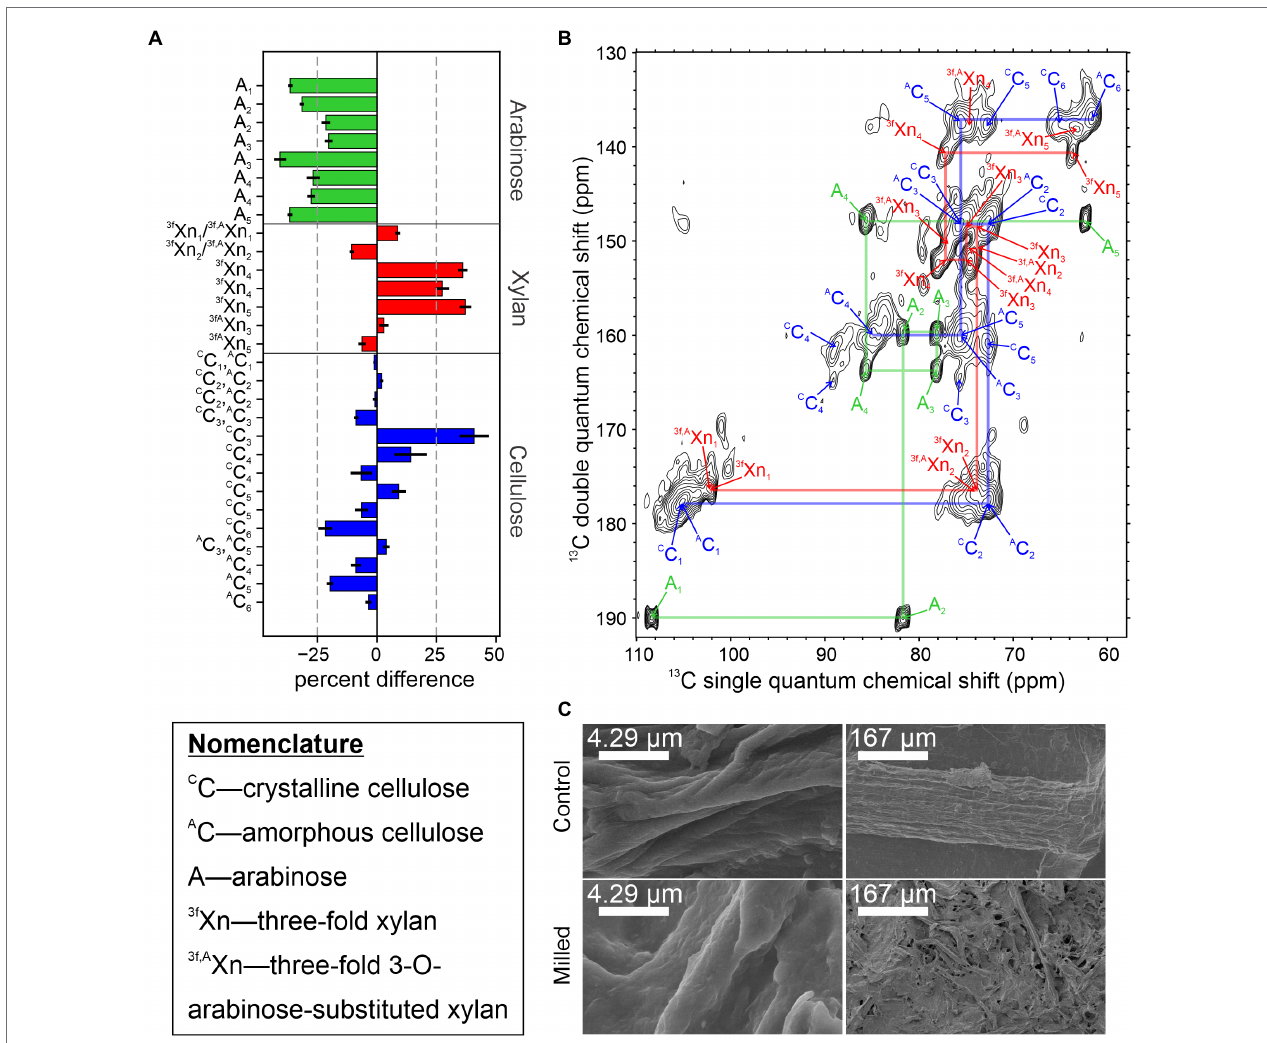
FIGURE 2 | Changes in the rigid structure of sorghum stem tissue after 2 min of ball milling. (A) Percent difference in integrated signal intensities from the 2 min ball-milled sample, relative to the unprocessed control sample. Due to the nature of the CP-INADEQUATE experiment, two signals are observed for most sites. Severely overlapping signals were omitted from this analysis. Error bars derive from the root-mean-squared noise in the spectra. (B) The CP-INADEQUATE spectrum of the unprocessed control sample. Semi-transparent lines are drawn to show the connections between signals within amorphous cellulose (blue), 3-fold xylan (red), and arabinosyl units from xylan (green). The spectrum was recorded at a 1 H frequency of 500 MHz with 10 kHz magic angle spinning and high power 1 H decoupling. (C) Field emission SEM images of the 2 min ball-milled and control samples. For all experiments, sorghum Tx430 was grown to maturity in a custom 13 CO 2 chamber as previously described (Gao and Mortimer, 2020), and the material used here had at least 92% 13 C incorporation. Ball milling was adapted from Kim and Ralph (2010), INADEQUATE experiments were performed according to Gao et al. (2020), and samples prepared for FE-SEM and imaged according to Zheng et al. (2020). NMR data were processed in NMRPipe (Delaglio et al., 1995) and plotted in Sparky (Lee et al.,